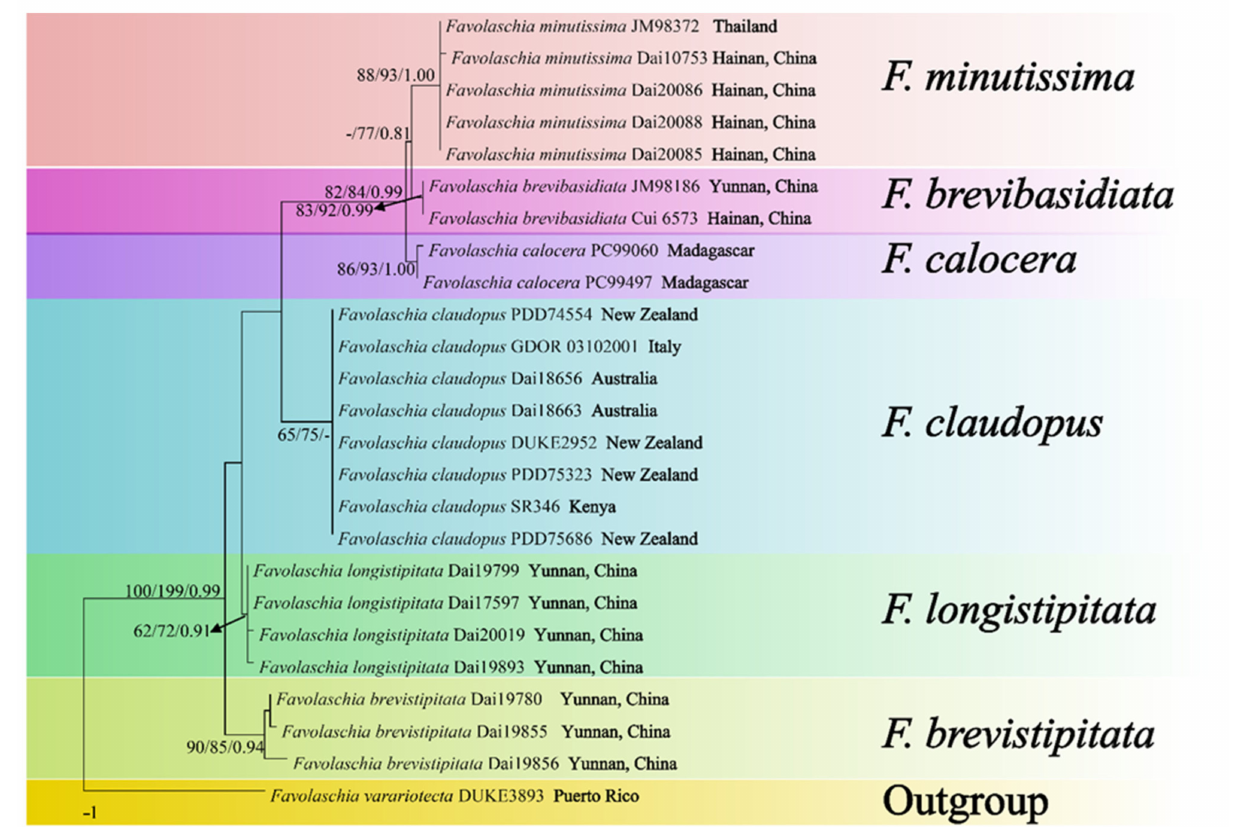
Figure 2. Maximum parsimony tree illustrating the phylogeny of the Favolaschia calocera complex based on ITS + nLSU + mt-SSU + nu-SSU + TEF1 sequences. Branches are labelled with parsimony bootstrap values higher than 50%, and Bayesian posterior probabilities more than